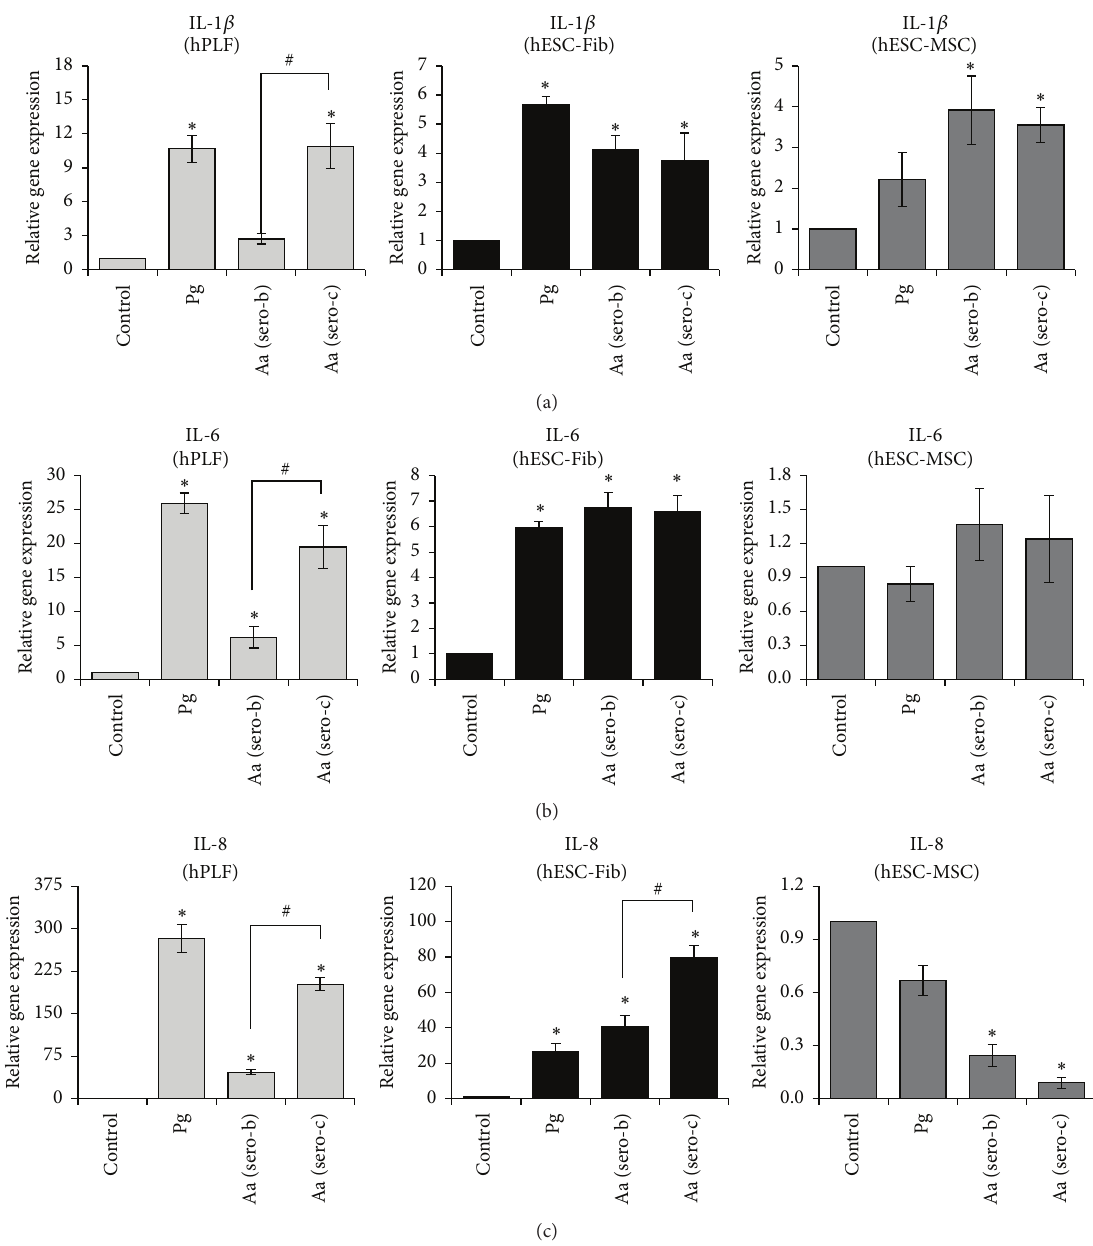
Figure 6: Transcript expression profiles of cytokines IL-1 𝛽 (a), IL-6 (b), and IL-8 (c) among hPLFs, hESC-Fib, and hESC-MSCs in response to P. gingivalis (Pg) and two different serotypes of A. actinomycetemcomitans (Aa serotypes b and c). The transcript levels were normalized to the respective 𝛽 -actin levels and to the untreated control sample. Values represent the means ± SD of three experiments ( ∗ 𝑝 < 0.05 versus untreated control; # 𝑝 < 0.05 versus different serotypes of A. actinomycetemcomitans